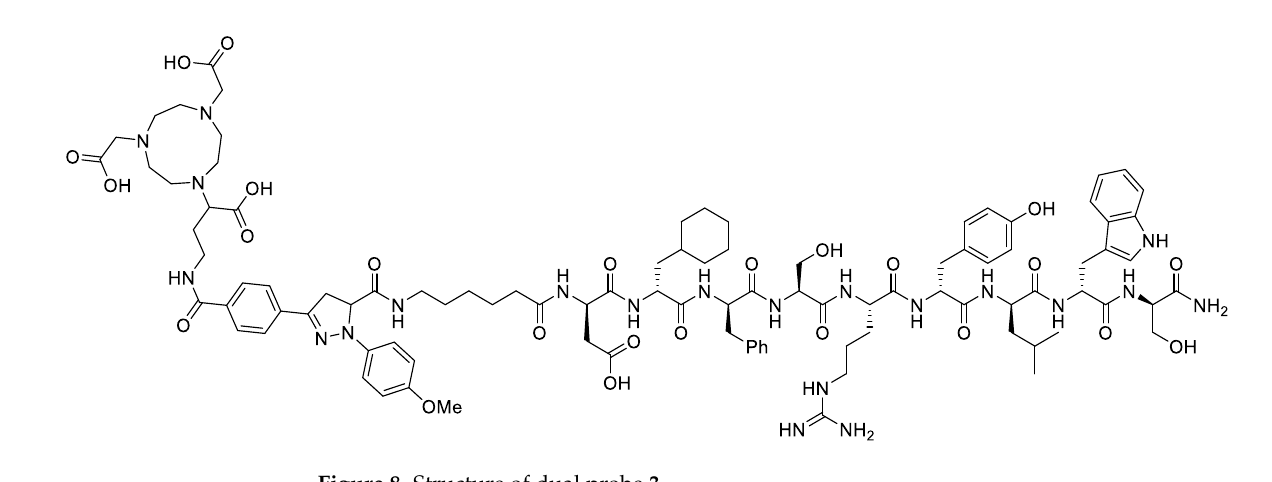
Figure 8. Structure of dual probe 3 .